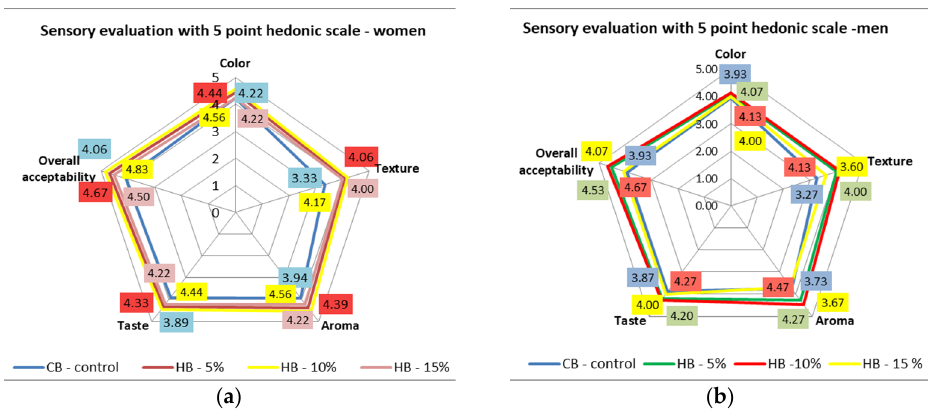
Figure 7. Mean scores of sensory attributes (color; texture; aroma and taste) for biscuits (CB–control, HB—5%, HB—10%, HB—15%) depending on gender (( a ) women; ( b )